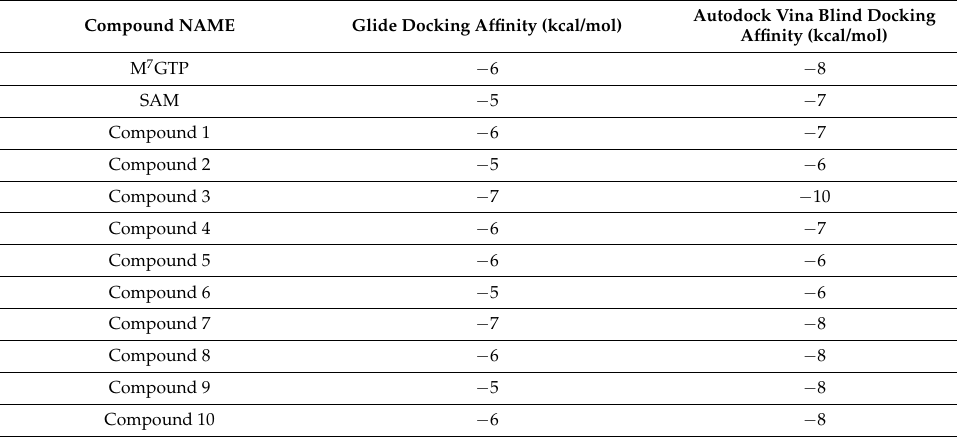
Table 2. HEV-MTase and compounds docking affinity